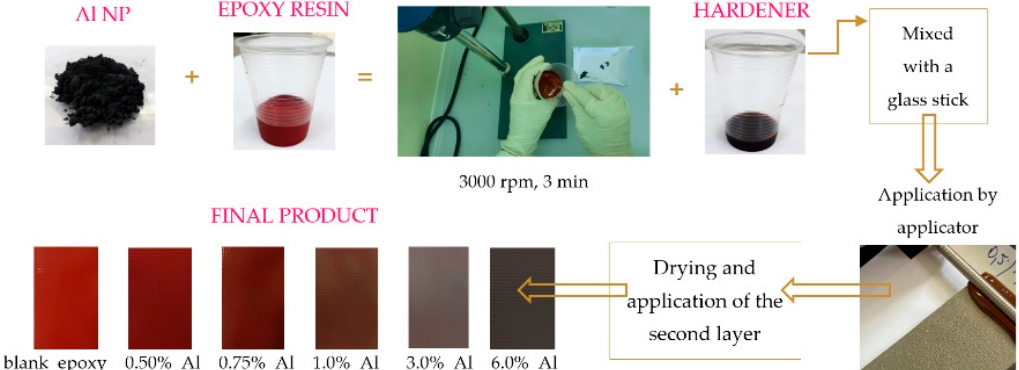
Figure 3. Description of modified nanocomposite coating preparation, application, and drying.